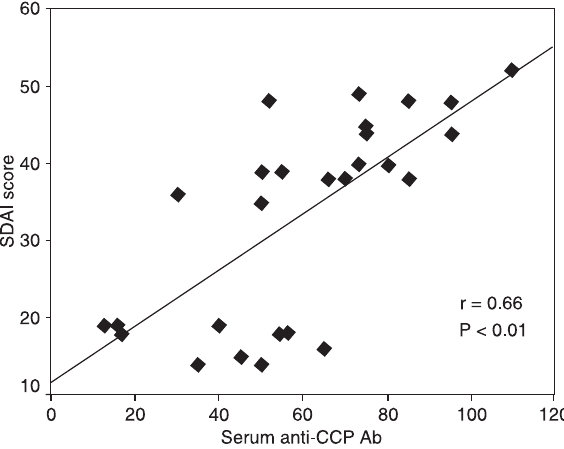
Figure 1. Correlation between serum anti-CCP Ab and SDAI score for 29 patients with rheumatoid arthritis. Anti-CCP Ab = anti-cyclic citrullinated peptide antibody; SDAI = simplified dis- ease activity index score for rheumatoid arthritis (Spearman rank correlation test).